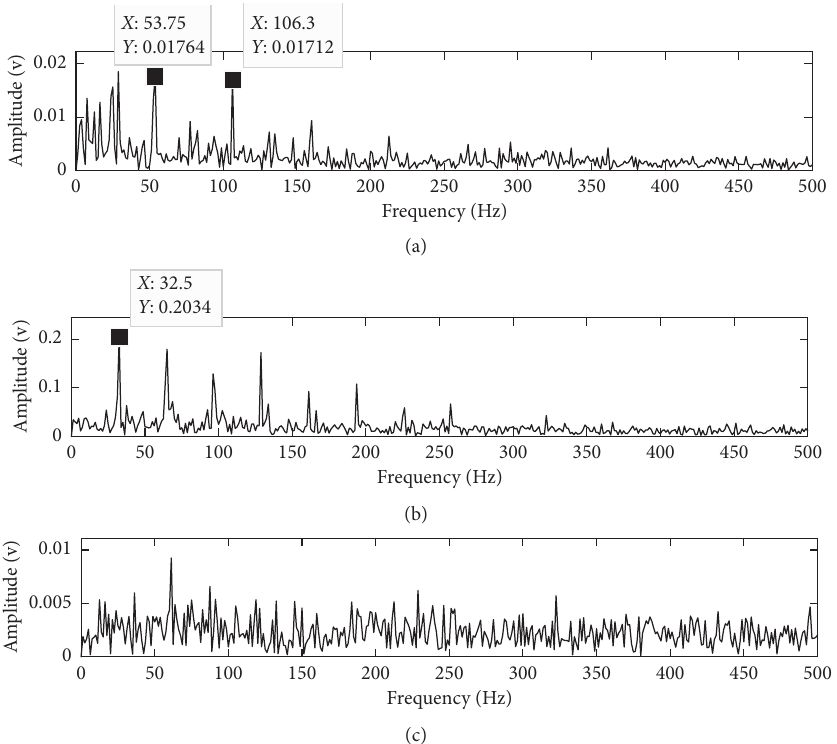
Figure 11: The envelope demodulation spectral analysis results of the signals as shown in Figure 10.